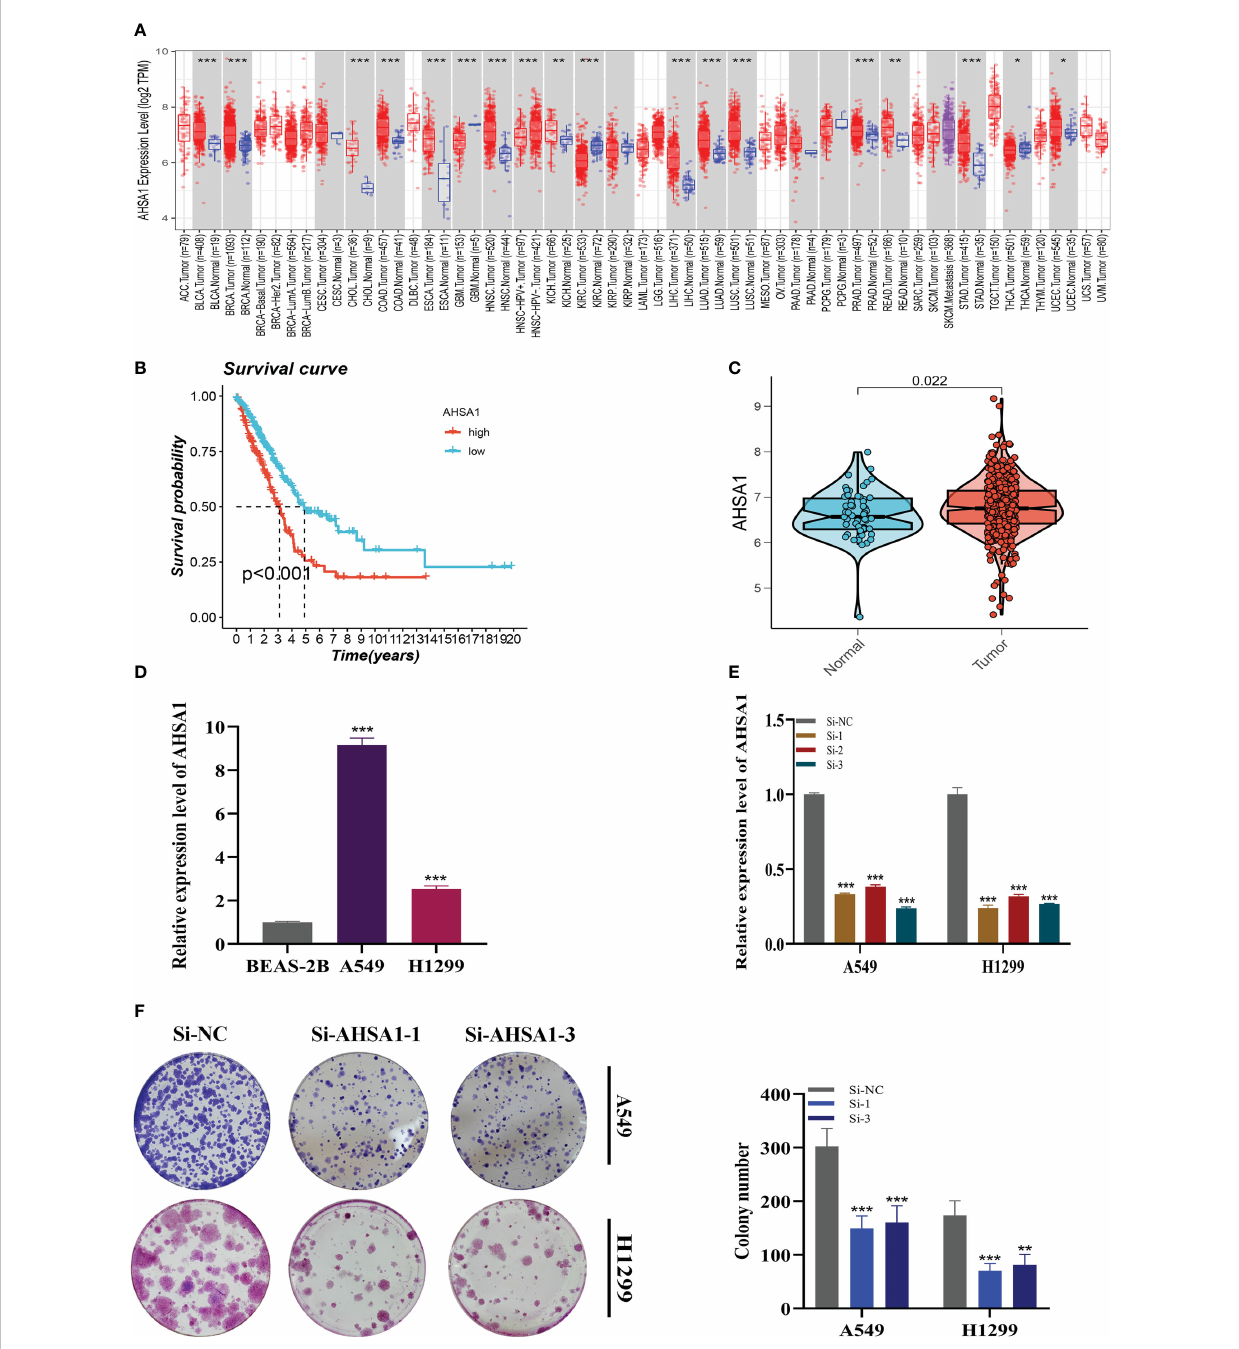
FIGURE 11 Cell Experiment. (A) The expression of AHSA1 in pan-cancer tissues was analyzed using the TIMER database. (B) Prognosis was evaluated by performing survival analysis on the effect of AHSA1 expression. (C) TCGA database analysis revealed a difference in AHSA1 expression between normal samples and tumor samples. (D) To assess AHSA1 expression, qRT-PCR was performed on both normal cells and LUAD cell lines. (E) The level of AHSA1 expression was evaluated 5 days after transfection using qRT-PCR, and signi fi cant reduction in AHSA1 expression (P< 0.001) was observed with siRNA sequences. (F) The number of colonies was signi fi cantly reduced in cells with reduced AHSA1 expression compared to the NC group, as shown by the colony formation assay. Note: *P < 0.05, **P < 0.01, ***P <